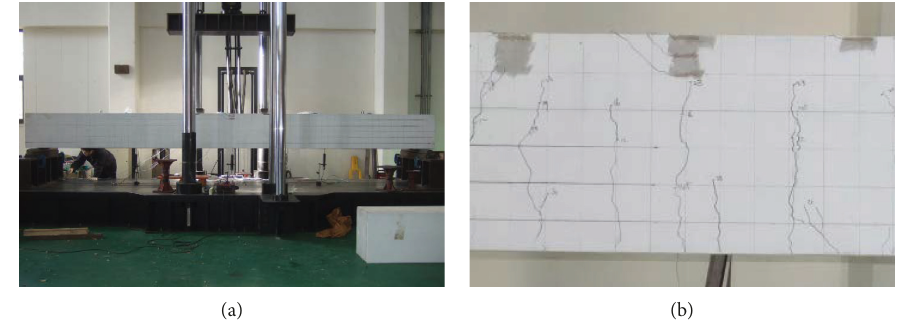
Figure 15: Loading test. (a) UTM setup. (b) Loaded specimen.